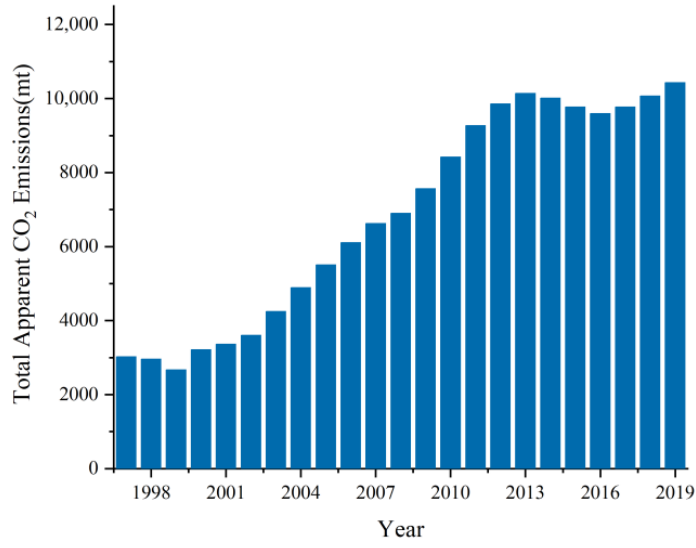
Figure 2. China ’ s total apparent CO 2 emissions over the years.